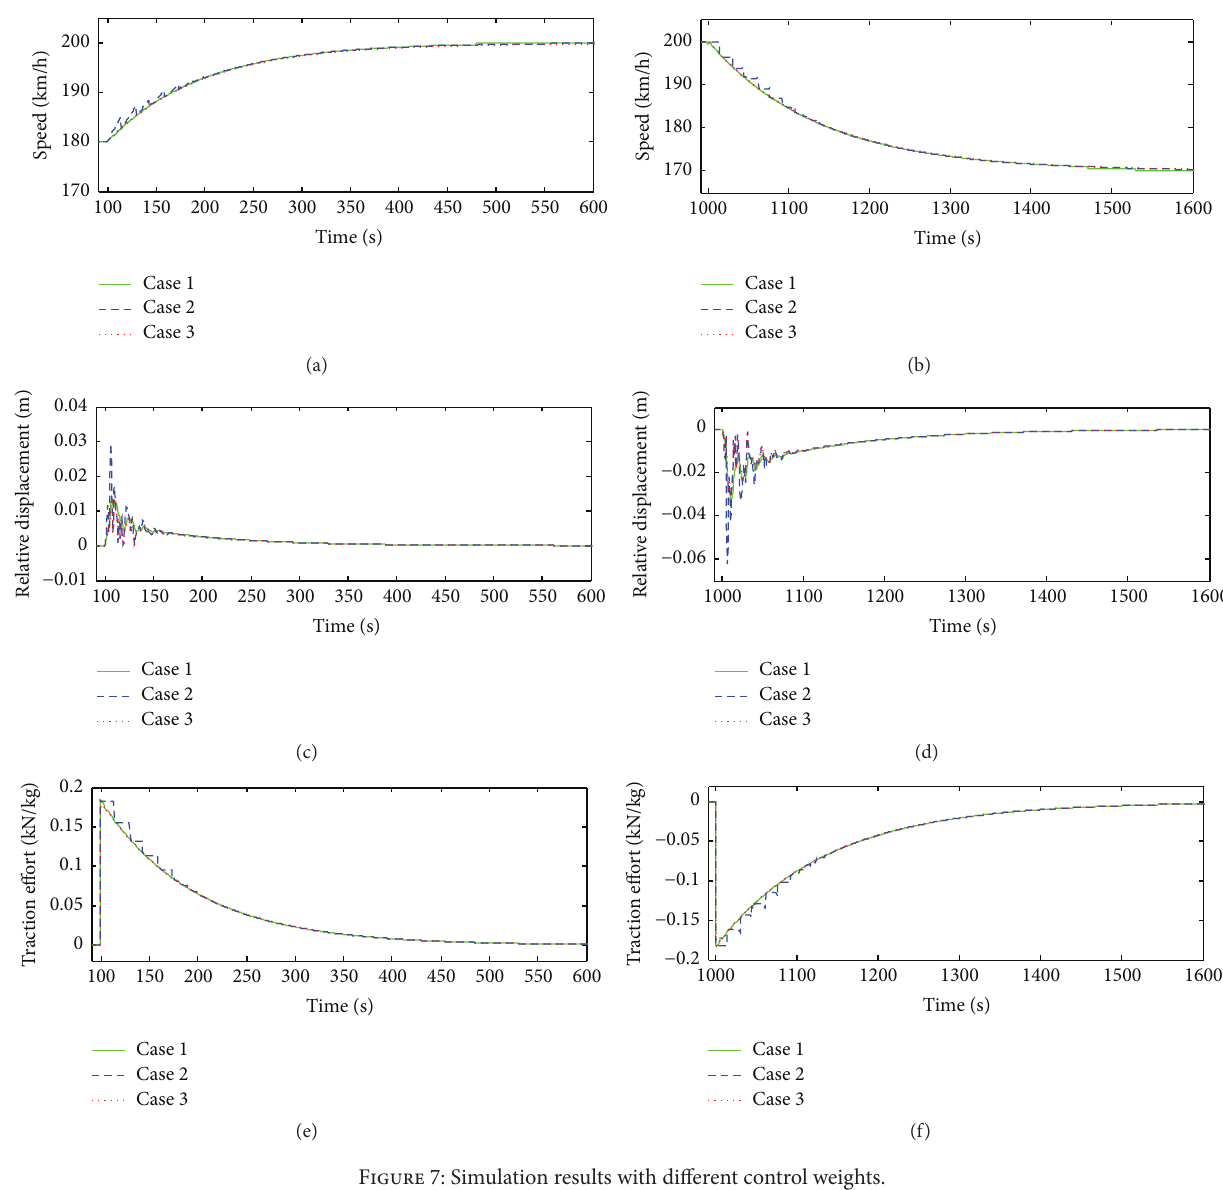
Figure 7: Simulation results with different control weights.